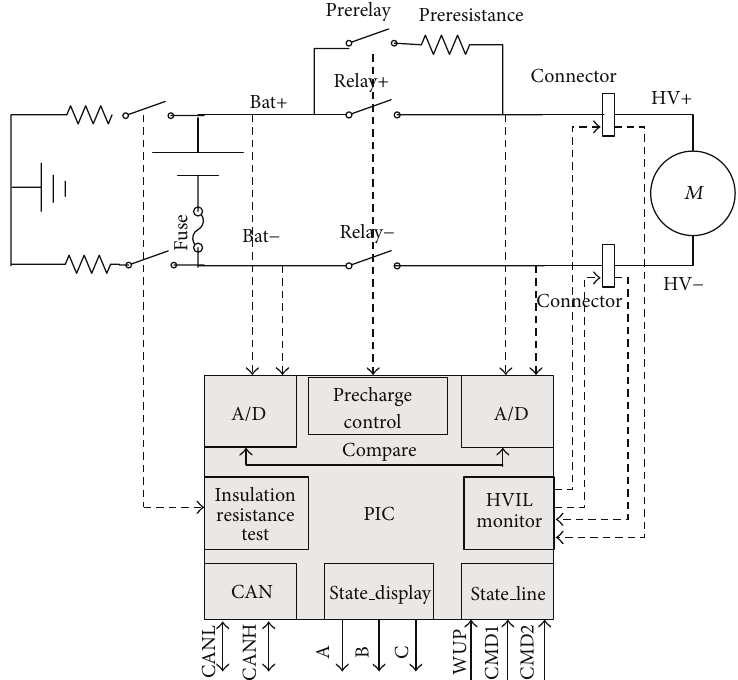
Figure 3: The structure of the high voltage safety management system.